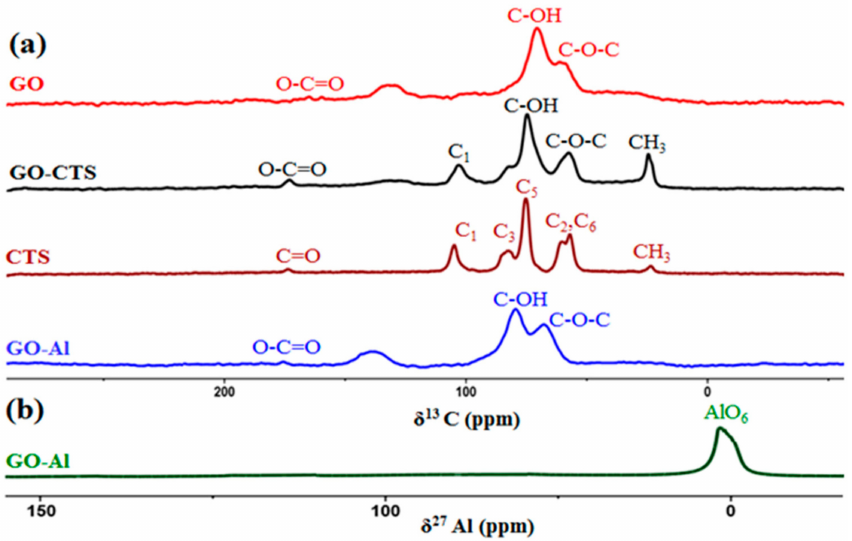
Figure 2. ( a ) Normalized 13 C and 27 Al solids NMR spectra of GO, chitosan and GO-based cross-linked composite (GO–CTS), and ( b ) 27 Al NMR spectrum of